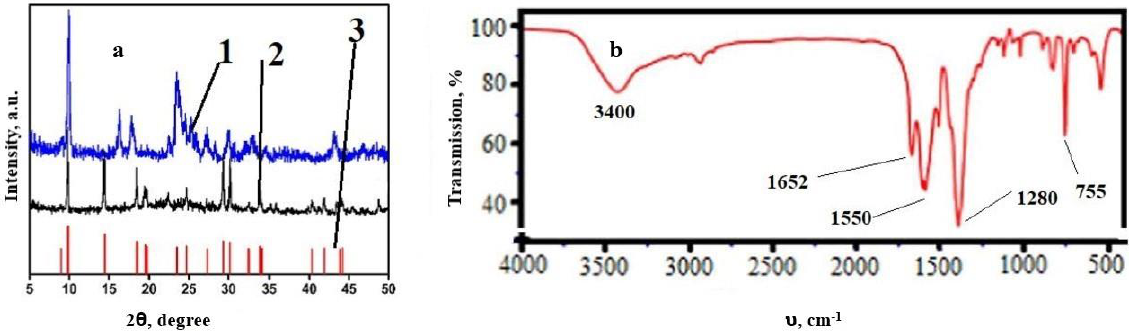
Figure 5. XRD ( a ) and IR spectrum ( b ) of cobalt terephthalate. 1 — Cobalt terephthalate dihydrate, 2 — sample dried in a vacuum with heating, 3 — peaks of the XRD profile stored in the international database (JCPDF 34-1896).